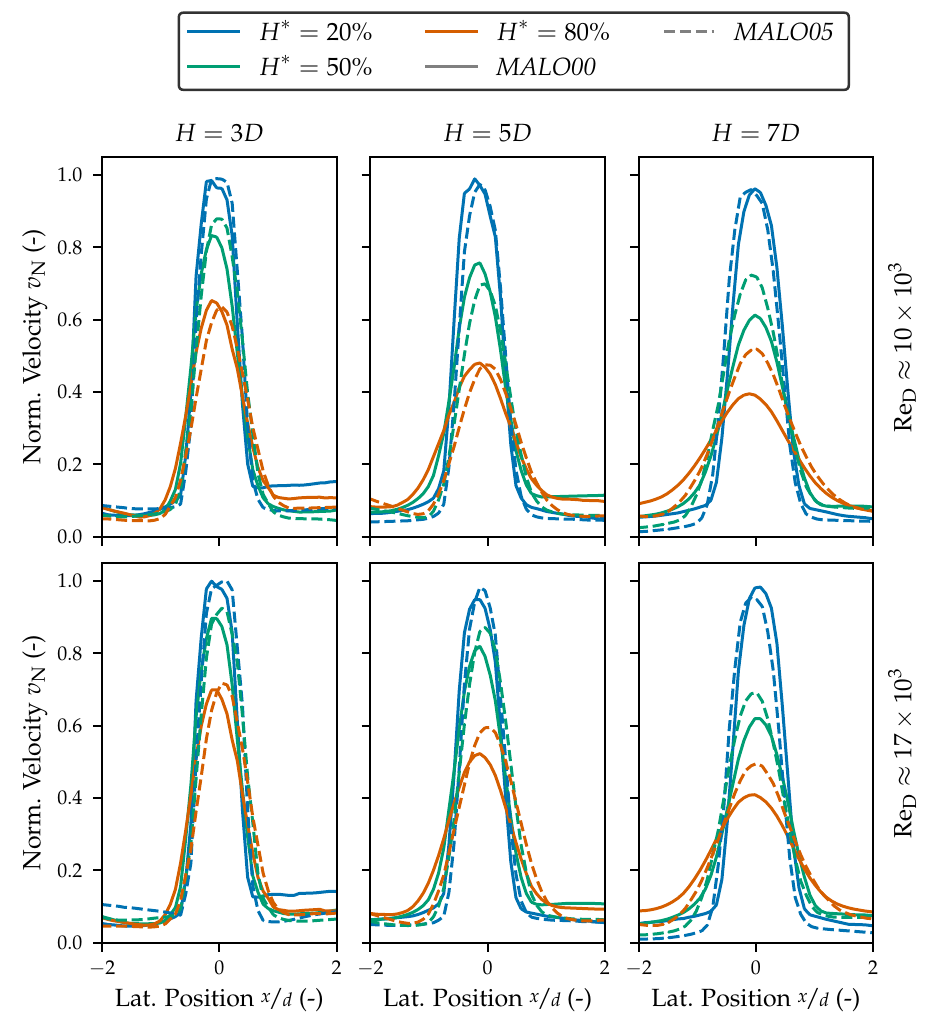
Figure 5. Jet profiles for all configurations tested. Profiles shown normalized velocity at three different height (colors) for both alignments (line style) at both Reynolds numbers (rows) and different cavity heights (columns). Velocities taken at y -normal